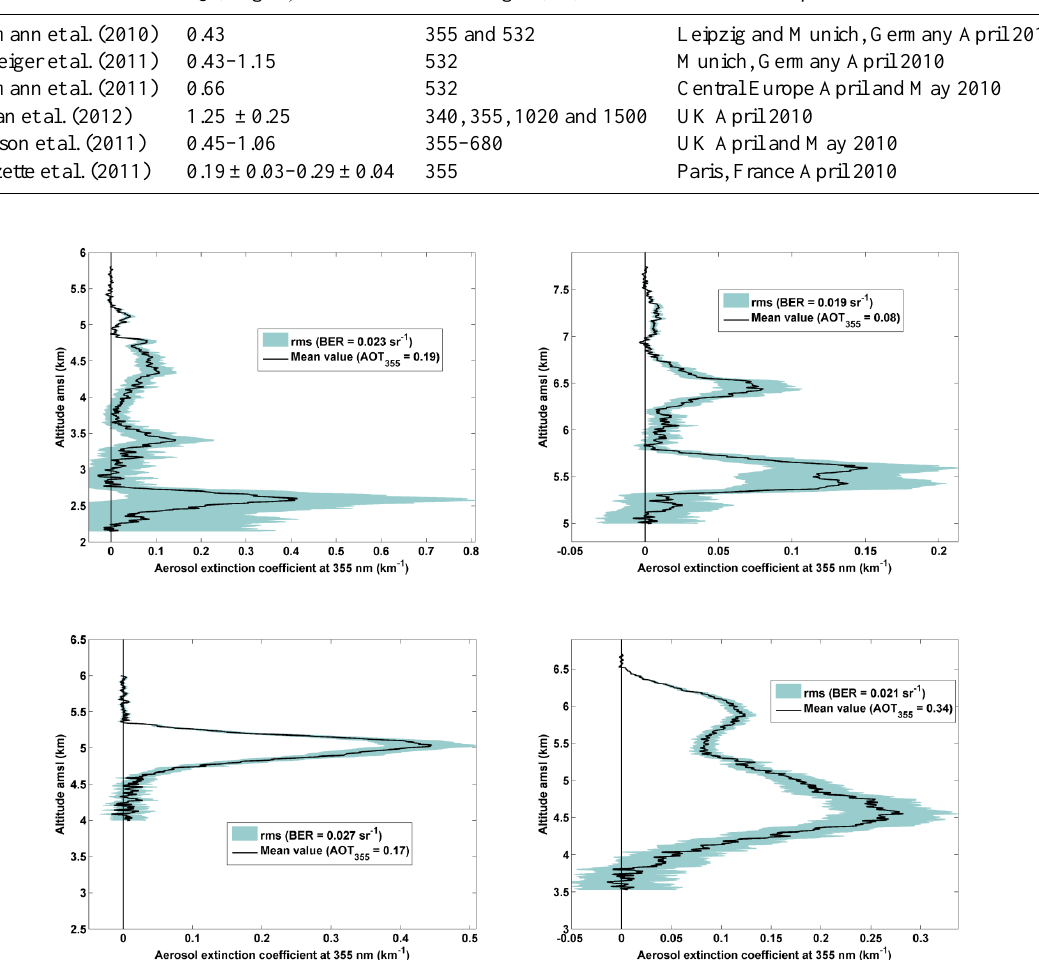
Fig. 9. Mean profiles of the aerosol extinction coefficient on 12 and 16 May 2010: top-left panel for the plume of 12 May, top-right panel for the plume crown of 12 May, bottom-left panel for the filament of 12 May, and bottom-right panel for the plume of 16 May. The standard deviation (rms) linked to the retrieval uncertainty is also given by the turquoise-blue area. The BER used for the inversion are also indicated. Note that the dynamics of figures are different.